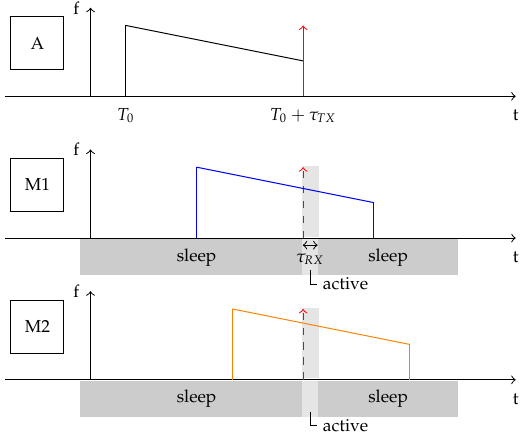
Figure 4. The hybrid acoustic-RF positioning system realizing a late wake-up of the mobile nodes. Depending on the distance to the anchor node (A), each mobile device (M1/M2) captures a different part of the emitted acoustic chirp signal at RF wake-up. In this case, M2 is located at a larger distance from the anchor node than M1. Both mobile devices only sample the acoustic signal during a short time period τ RX , minimizing the energy